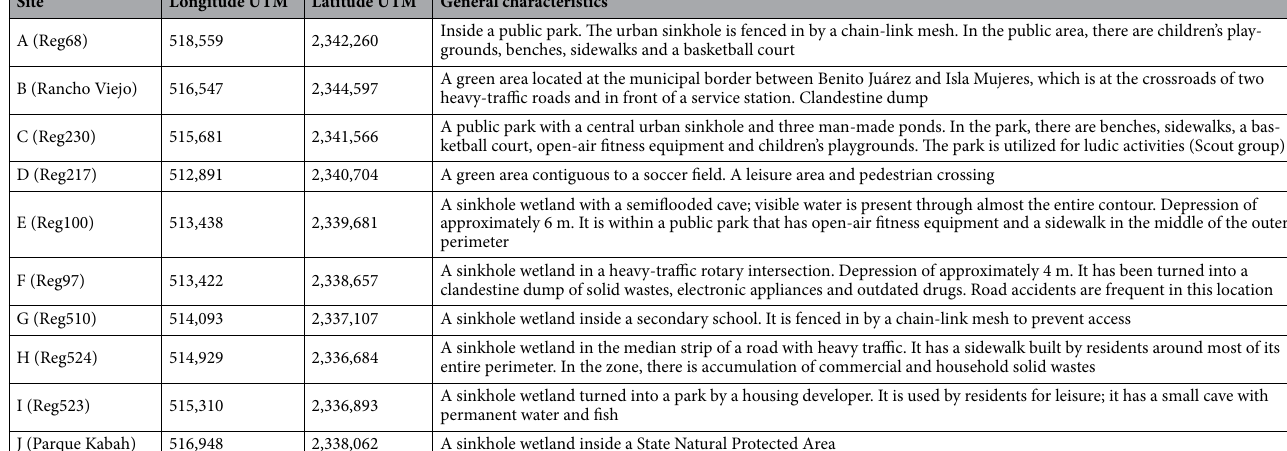
Table 1. General characteristics of the urban sinkholes studied in